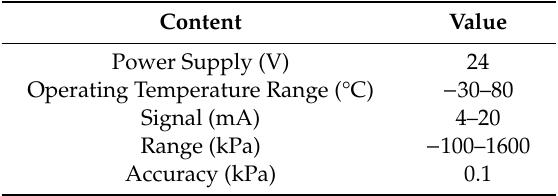
Table 5. The main technical parameters of the pressure